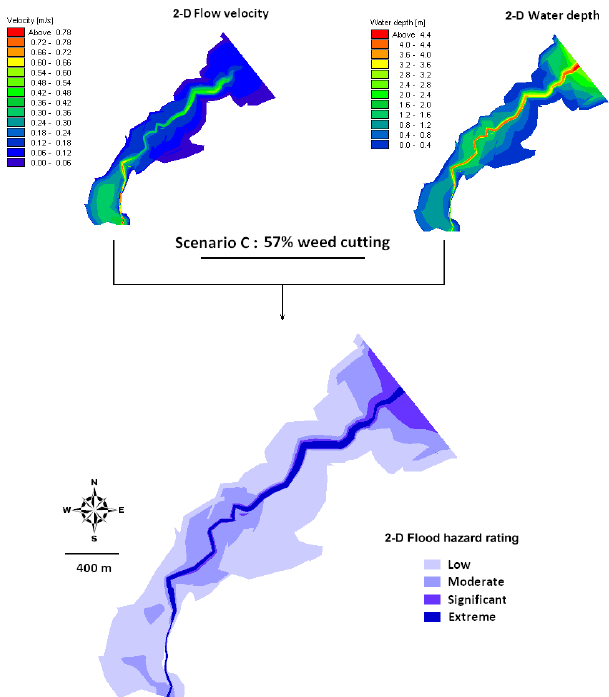
Fig. 6. Flow velocity, flood inundation and flood hazard rating maps for scenario C (57% weed cutting).